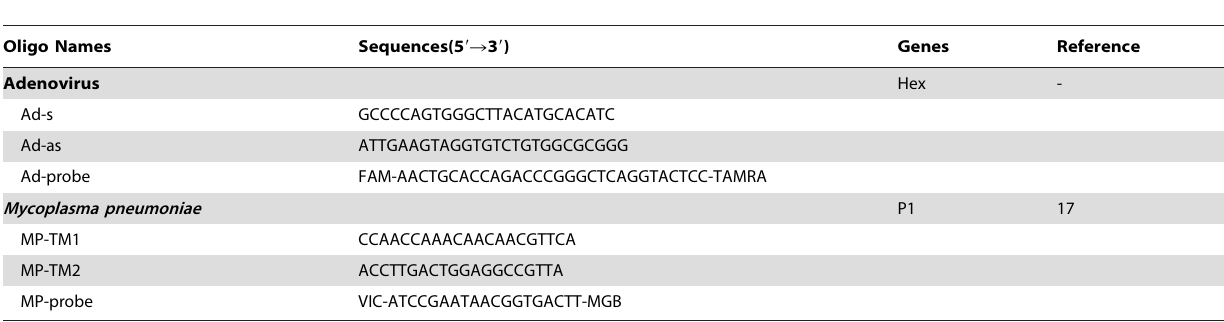
Table 1. The sequences of primers and probes of adenovirus and Mycoplasma